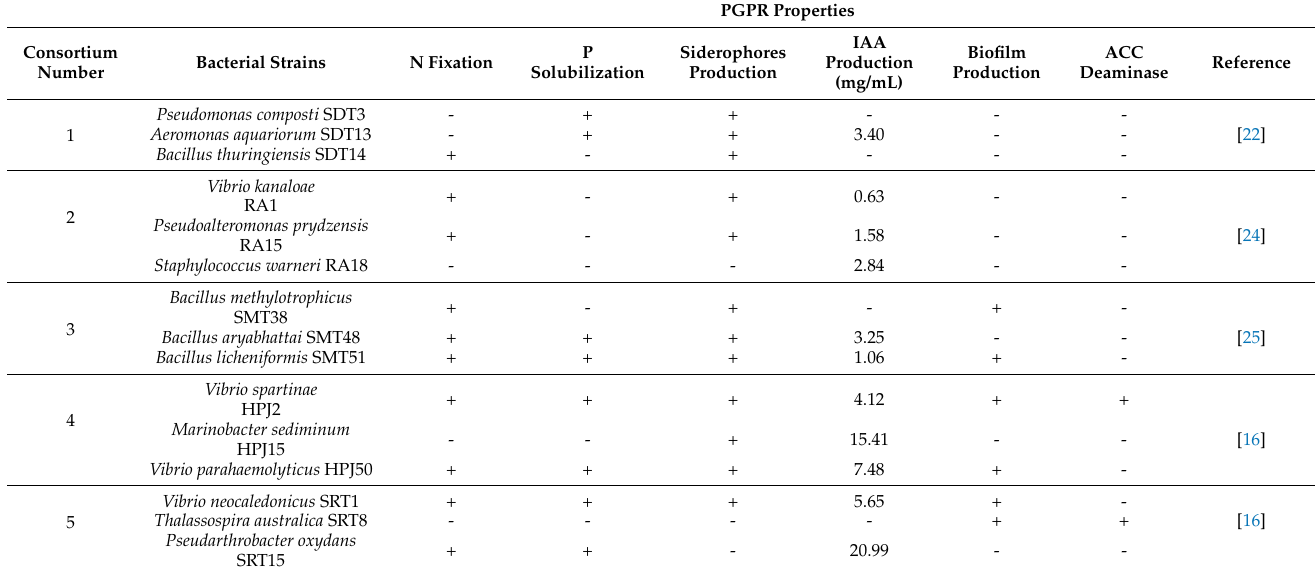
Table 1. Plant-growth-promoting rhizobacterial (PGPR) traits for consortia used in this